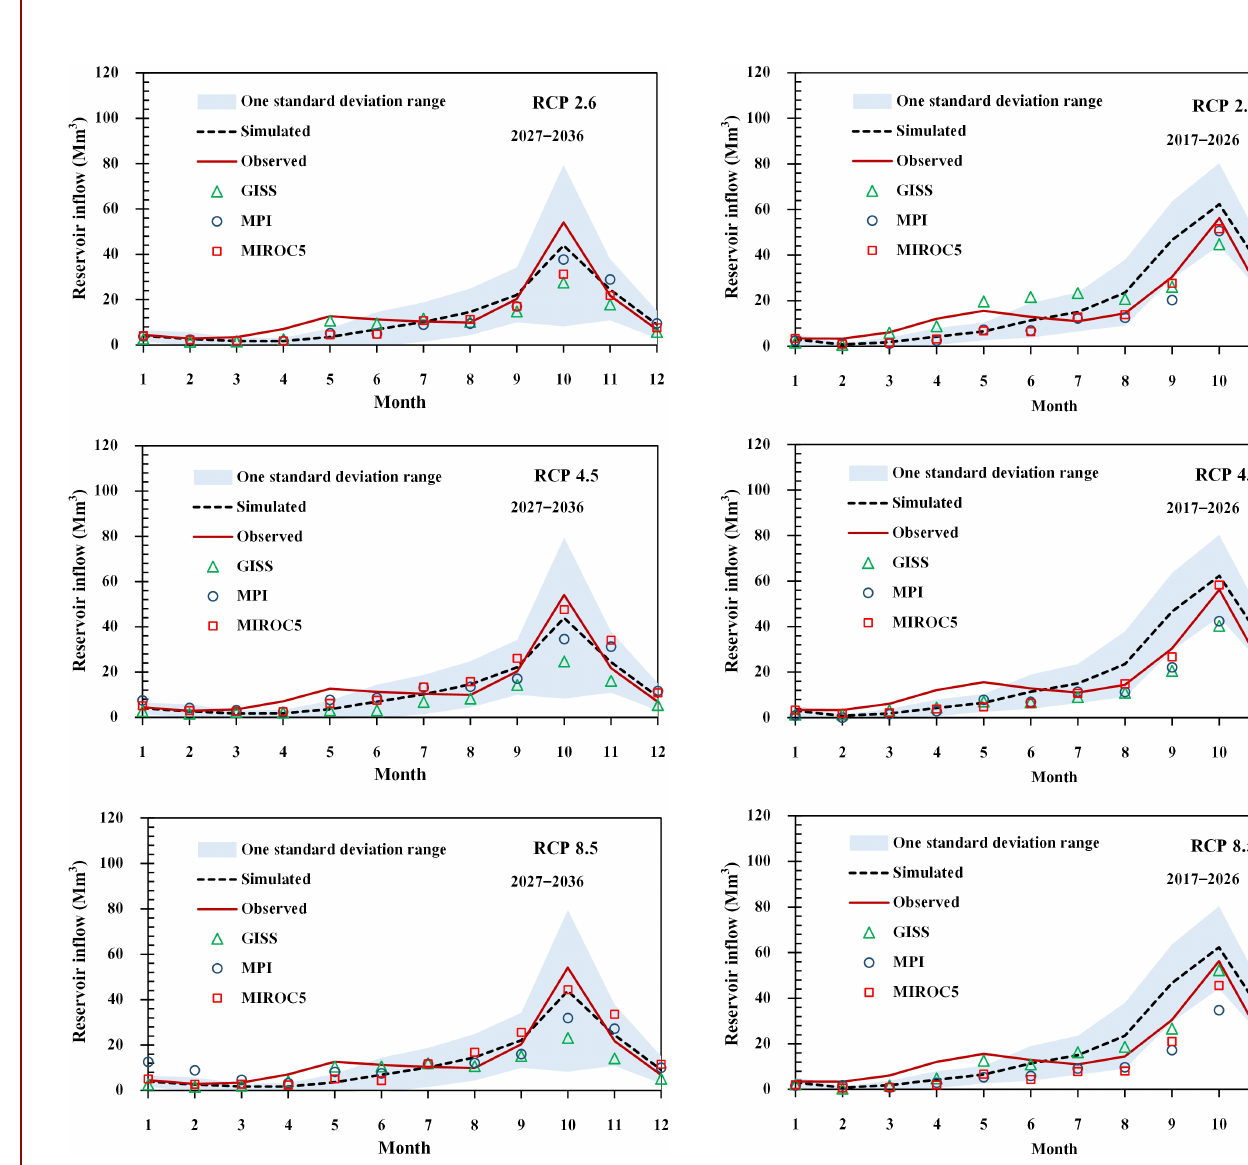
Figure 9. Projected mean monthly reservoir inflows under 3 sce- narios for the years 2027–2036 at Dok Krai Resevoir.